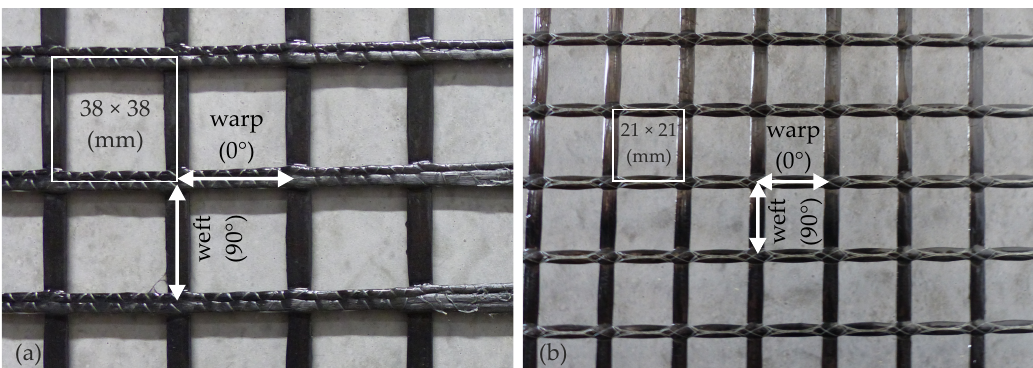
Figure 5. Textile grids made of carbon with epoxy impregnation with a mesh size of 38 mm ( a ) and 21 mm (( b ), photographs by IMB, RWTH Aachen University).